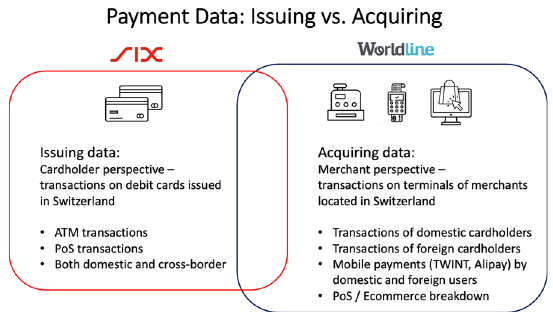
Fig. 1 Payment processing data: acquiring vs. issuing. Note : The figure displays the origin of the transaction data. The data originate from two sources: Transactions recorded when generated by specific debit cards, provided by SIX (card issuer perspective); and transactions from arbitrary payment cards recorded at the payment terminal, provided by Worldline (acquiring